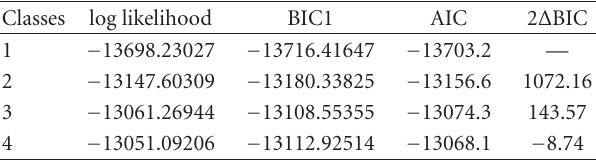
Table 3: Determining the number of classes for stressful life events excluding health items.